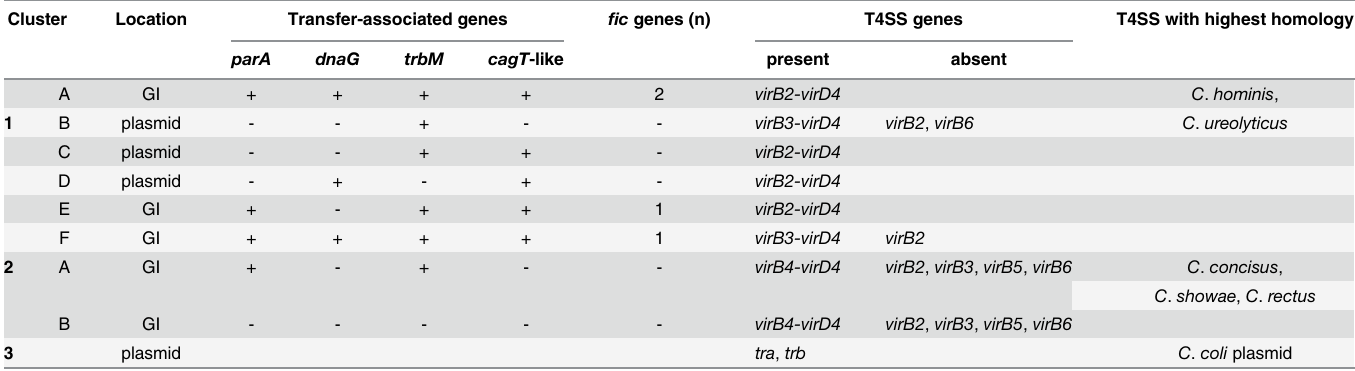
Table 2. Typical features of C. fetus T4SS encoding regions. Cluster